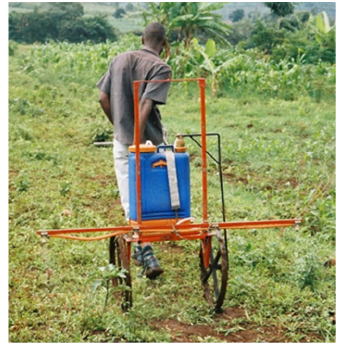
Figure 9. A back ‐ pack sprayer mounted on a wheeled chassis. The sprayer pump is actuated by an Figure 9. A back-pack sprayer mounted on a wheeled chassis. The sprayer pump is actuated by